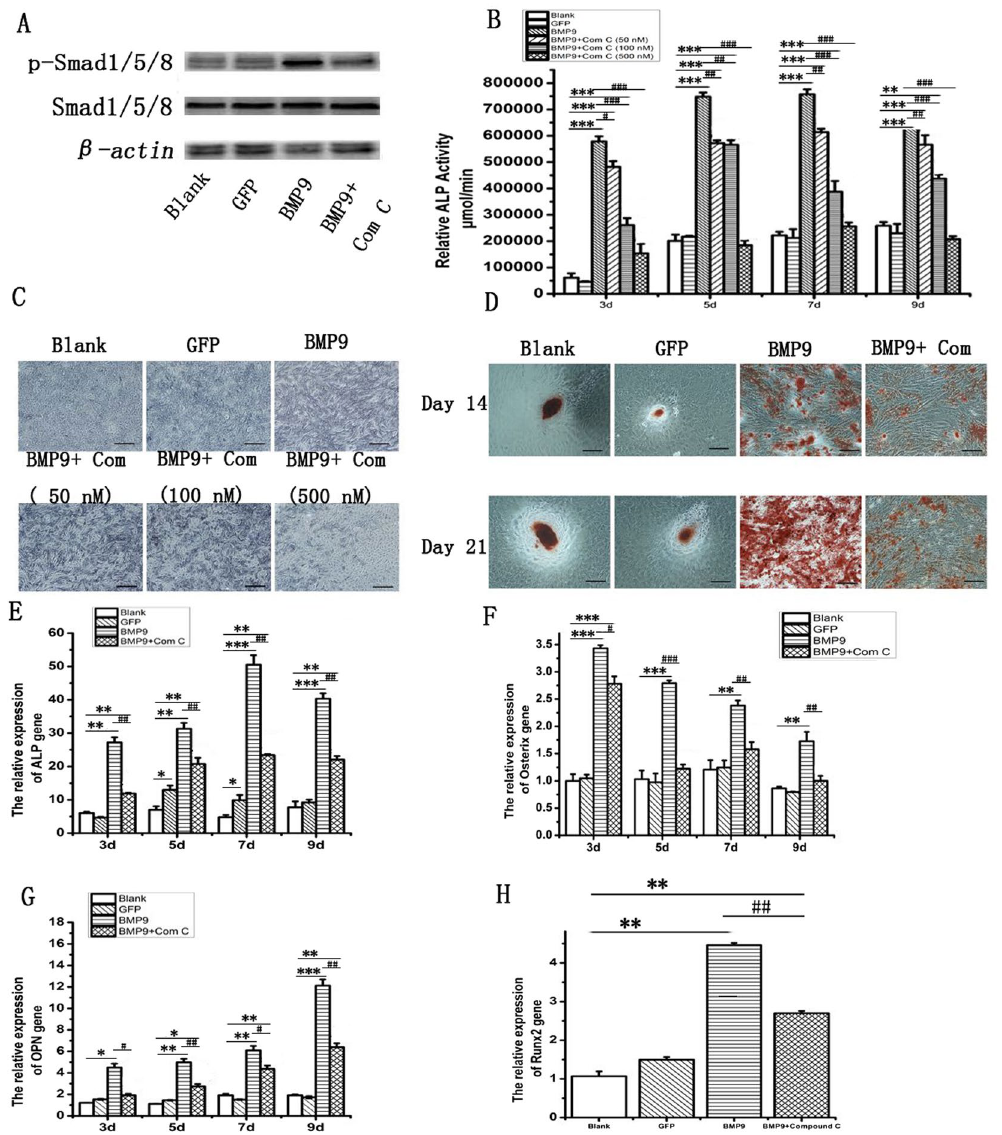
Figure 5. Activation of Smad1/5/8 signaling pathway is involved in BMP9-induced osteogenic differentiation of rDFCs. ( A ) Western Blot assay showed that BMP9 activated the Smad1/5/8 signaling pathway and increased the expression of phosphorylation Smad1/5/8. ( B ) ALP activity assay showed effect of Smad1/5/8 signaling pathway inhibition on rDFCs osteogenic differentiation by Compound C in a dose-dependent manner. ( C ) Effect of Smad1/5/8 signaling pathway inhibition on osteogenic differentiation of rDFCs in a concentration manner. ALP staining on day 7 was showed. Black bars: 100 μ m. ( D ) Alizarin red staining was used to detect the calcium deposition on days 14 and 21. Black bars: 100 μ m. ( E , F , G and H ) osteogenic markers detected by Real Time- q PCR on days 3, 5, 7, 9. ( E ) Alkaline phosphatase, ALP. ( F ) Osterix, ( G ) Osteopontin, OPN. ( H ) runt-related transcription factor 2, Runx2. * P < 0.05, compared with blank group, ** P < 0.01, *** P < 0.001 compared with blank group, # P < 0.05, ## P < 0.01, ### P < 0.001, compared with BMP9